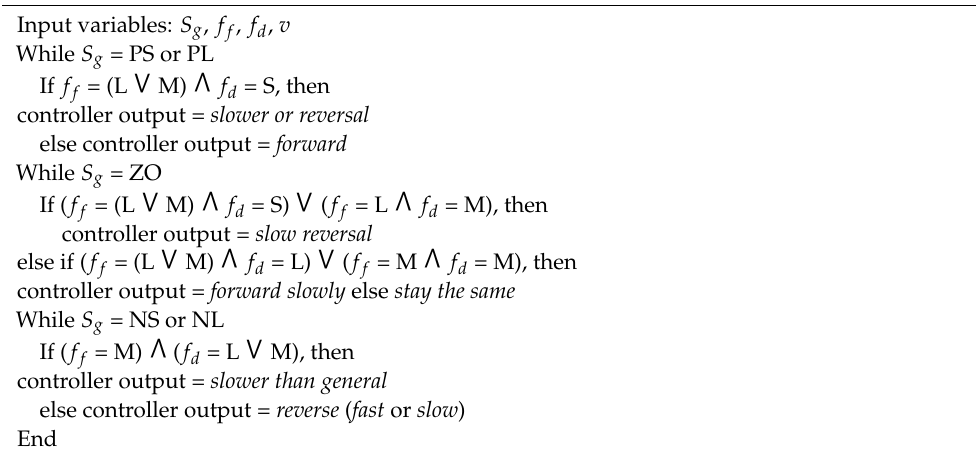
Algorithm 1: Power assistance with user’s posture ( v = ZO)